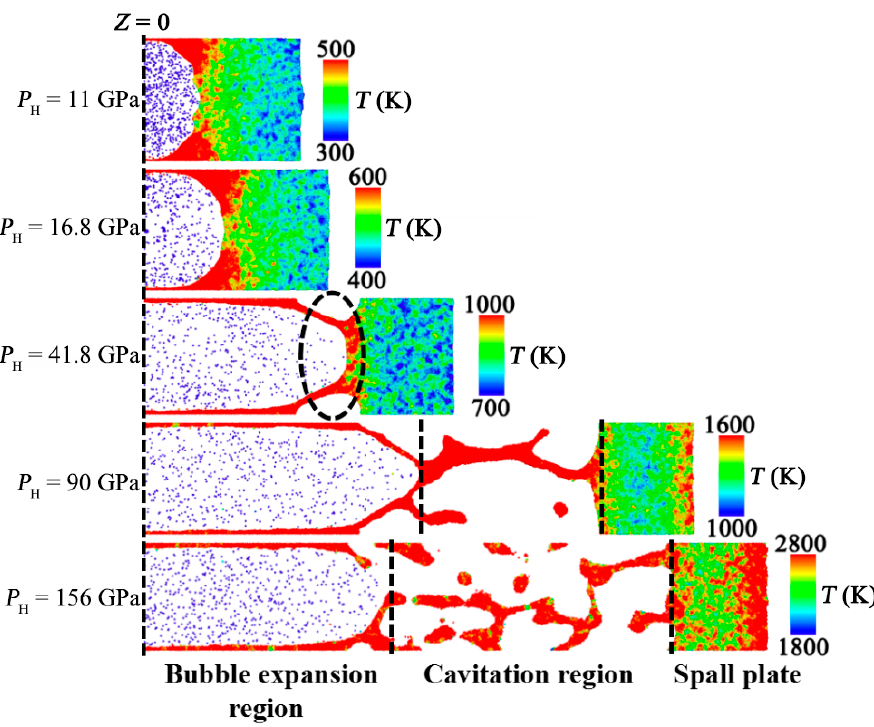
Figure 9. Final configurations of spallation under various Hugoniot states. Here, the right half of model is selected.